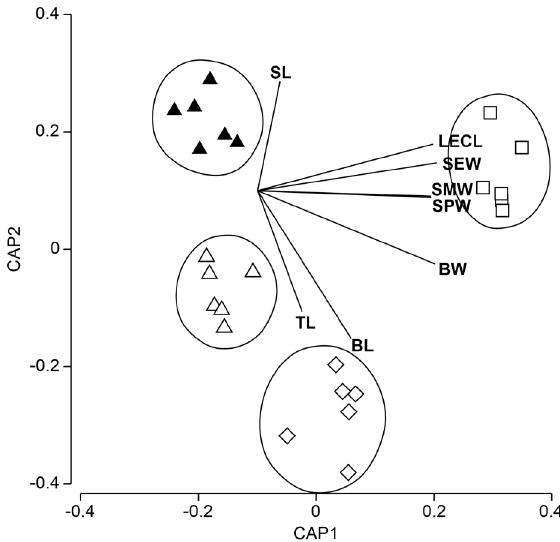
Figure 31 - Biplot of CAP analysis based on euclidean distances on 9 measurements of ventral anchors. Vectors represent the Spearman correlations of each morphometric measurement to the CAP axes. Black triangle = Rhinoxenus argentinensis n. sp.; white triangle = Rhinoxenus paranaensis n. sp.; rhombus = Rhinoxenus piranhus ; square = Rhinoxenus euryxenus . Abbreviations see Table